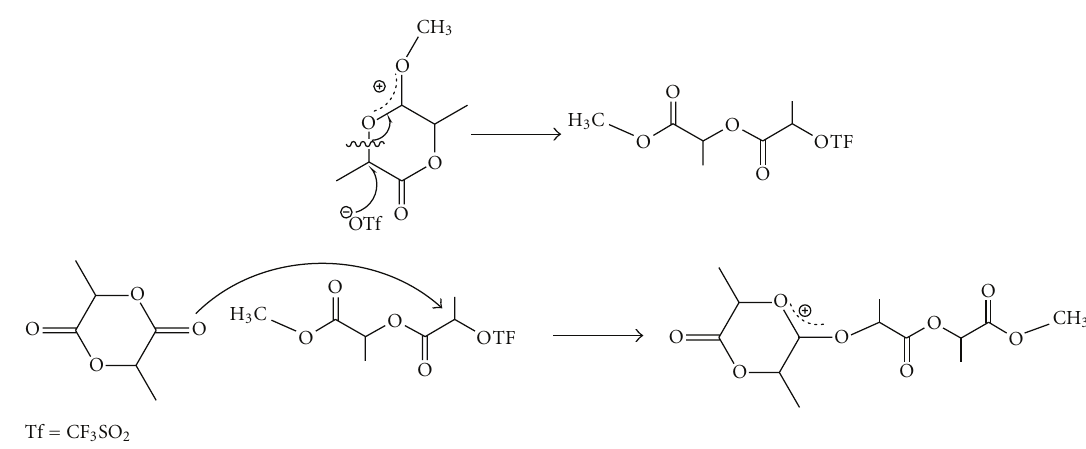
Scheme 5: Proposed pathway for cationic ring-opening polymerization of